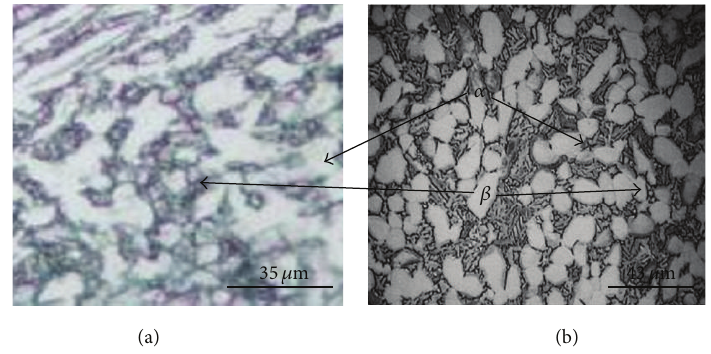
Figure 3: Optical micrographs of (a) Ti-6Al-7Nb and (b) Ti-6Al-4V alloys.